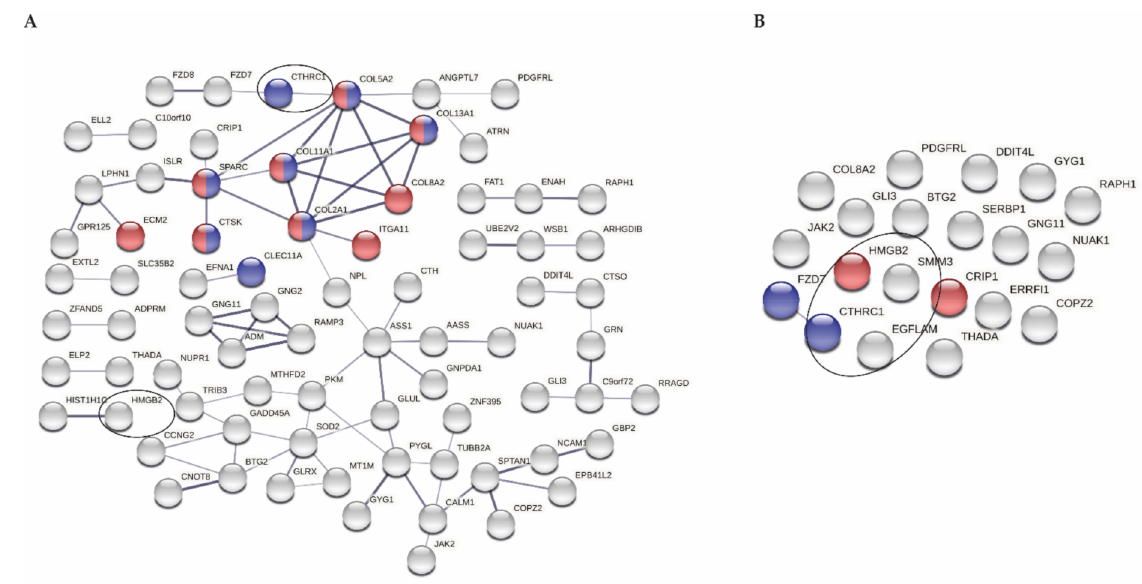
Figure 2. Protein–protein network. ( A ) STRING analysis for 114 genes included in whole correlation analyses; indicated in red and blue are significantly enriched pathways (extracellular matrix and ossification, respectively; disconnected nodes are hidden). ( B ) STRING analysis for 21 unique genes strongly correlating to 34 miRNAs; ρ ≥ |0.7|; indicated in red and blue are significantly enriched pathways (DNA binding and Wnt-protein binding, respectively). Circles point at the 4 genes strongly correlating to levels of at least 10 different plasma miRNAs ( EGFLAM and SMIM3 are disconnected in ( A )). Note: LINC00115 is missing because this is a non-coding